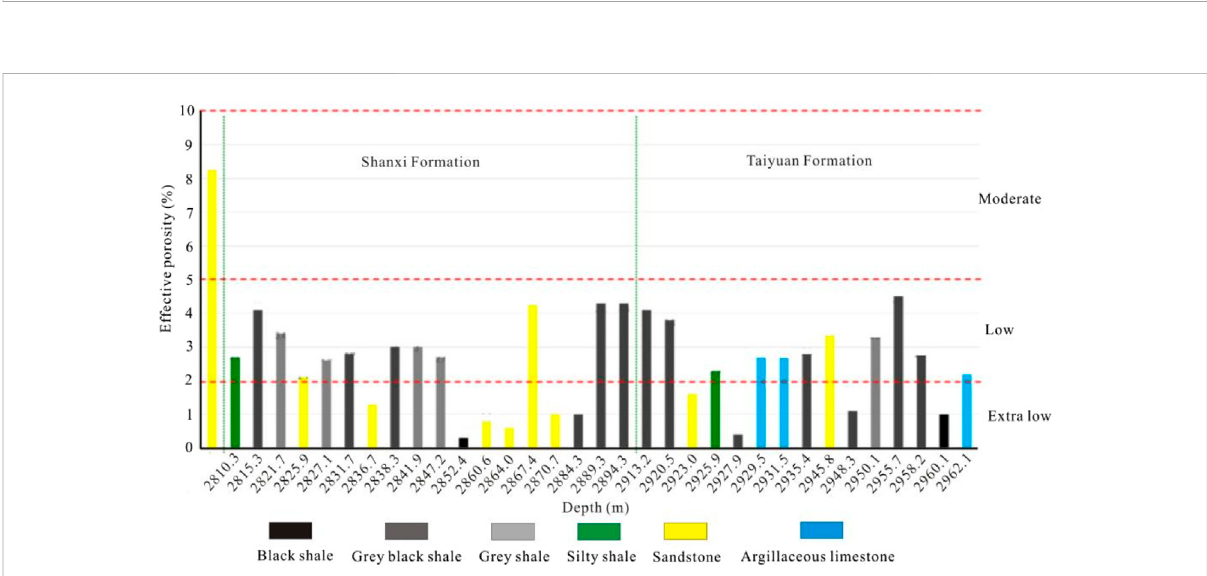
FIGURE 5 Histogram of effective porosity distribution of rock samples from Well